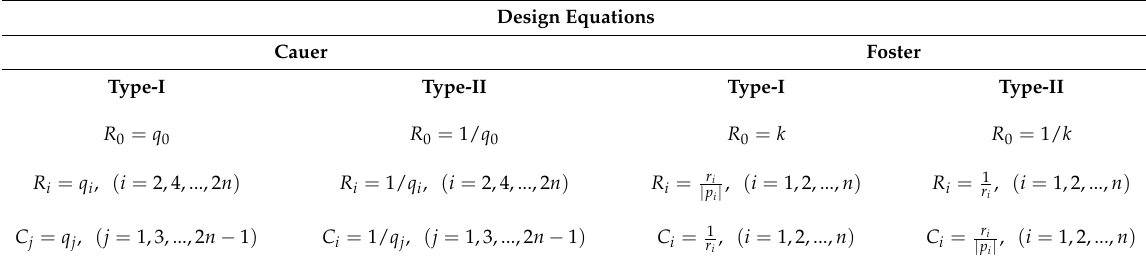
Table 1. Design equations of the Cauer and Foster types of RC networks